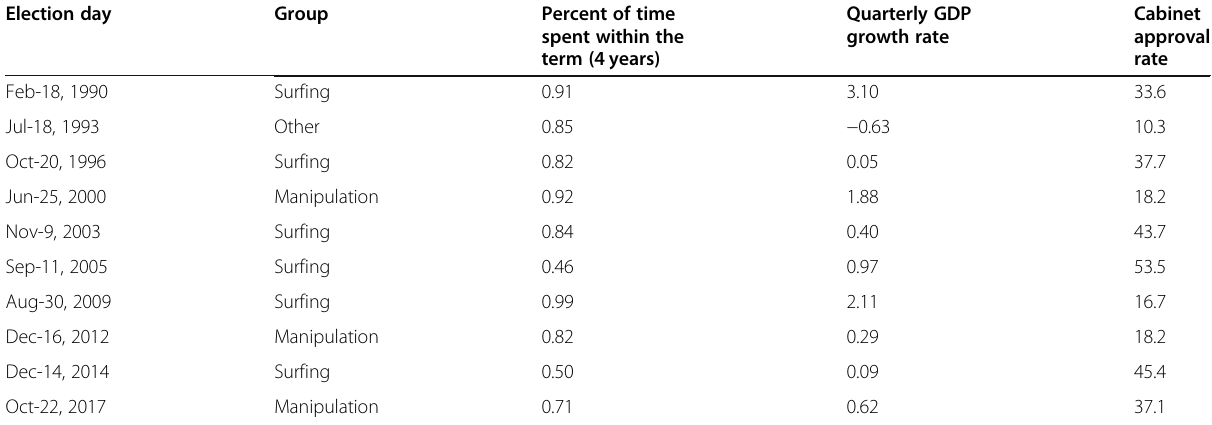
Table 3 Categorization of Elections from 1986 to 2018 Election day Group